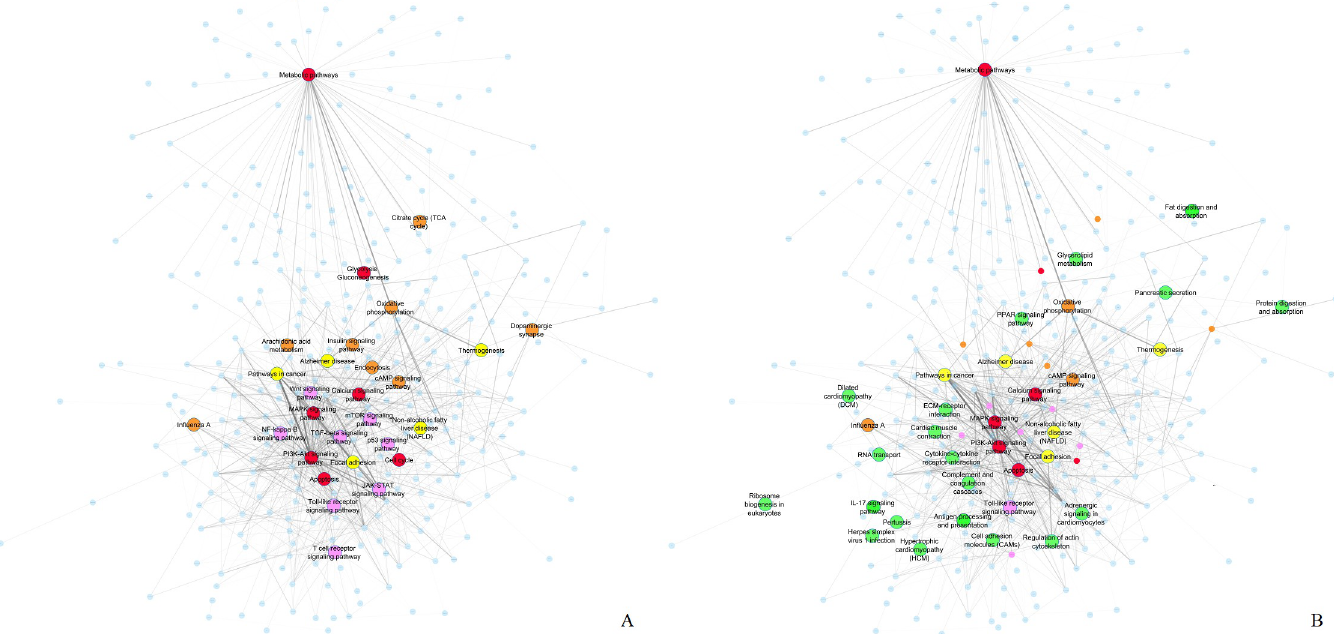
Fig 3. PathWalks pathway-pathway network component. A. The base pathway-to-pathway network, common for all 9 diseases. An edge indicates a functional connection between two pathways according to KEGG, and its thickness is relative to the number of their common genes. Orange nodes belong to the top- 5 % of pathways with the highest betweenness centrality, pink nodes to the top- 5 % with the highest degree and red nodes to both groups. Yellow nodes depict pathways that do not belong in any of these groups but still reach the top- 5 % in the results of a no-map PathWalks execution (i.e., random pathway selections) due to their high functional connectivity edge values. All colored nodes are more likely to appear in the results due to their topological characteristics rather than due to direct relation with the genetic information networks of each disease. B. We highlight nodes from Fig 3A that are exclusively based on the guidance of the gene maps in green color. We label all nodes that were produced in the top- 5 % of any PathWalks experiment. We observe that not every topologically-favored node is highlighted by PathWalks. Hence, we believe that even the topologically-favored nodes that are highlighted by the algorithm are not necessarily false-positive entries and should be further explored regarding